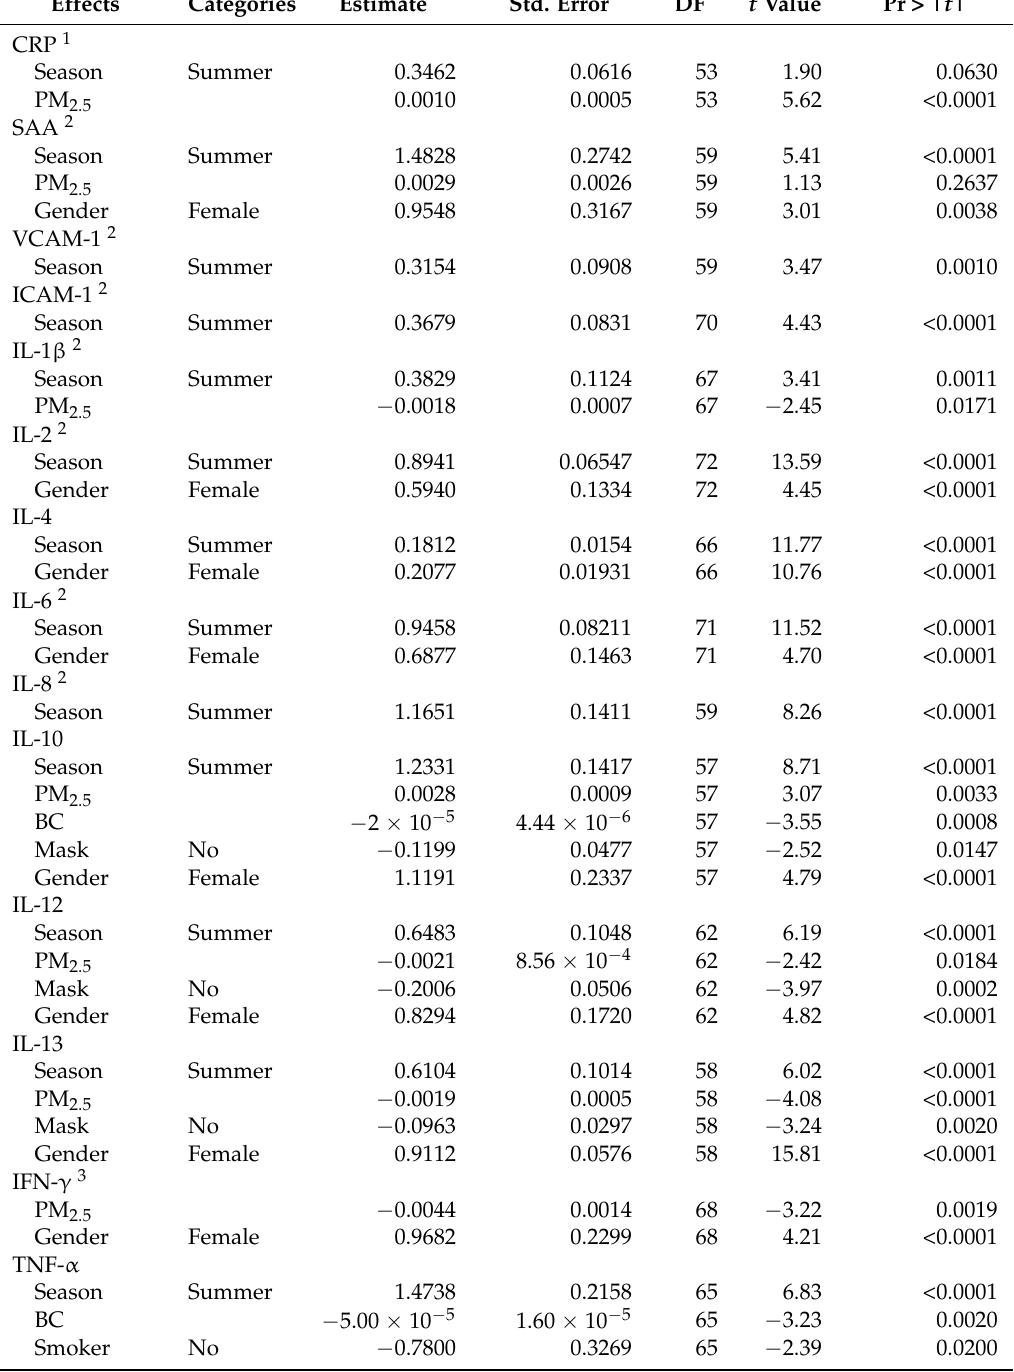
Table 3. Effects estimate from linear mixed